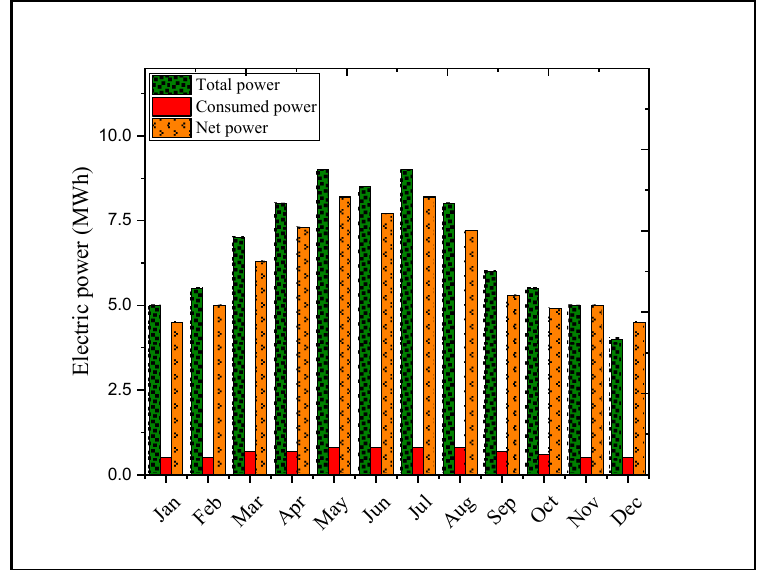
Figure 6. The amount of electricity produced, the amount of electricity consumed and the amount of monthly useful electrical energy in the city of Kerman.